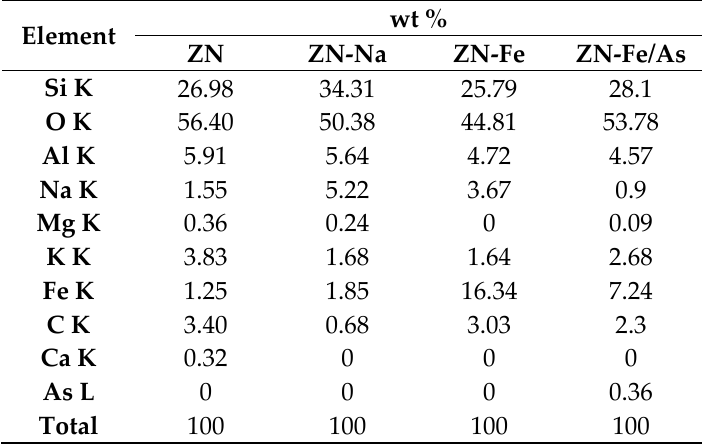
Figure 1. ( a ) XRD diffractograms of the natural and conditioned zeolite, ( b ) FTIR spectrums of the natural and conditioned zeolite. Table 2. SEM/EDS analysis of natural and conditioned